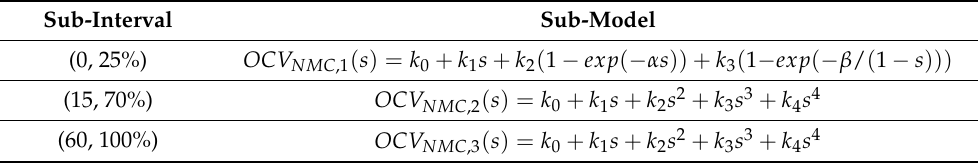
Table 1. Sub-models of NMC